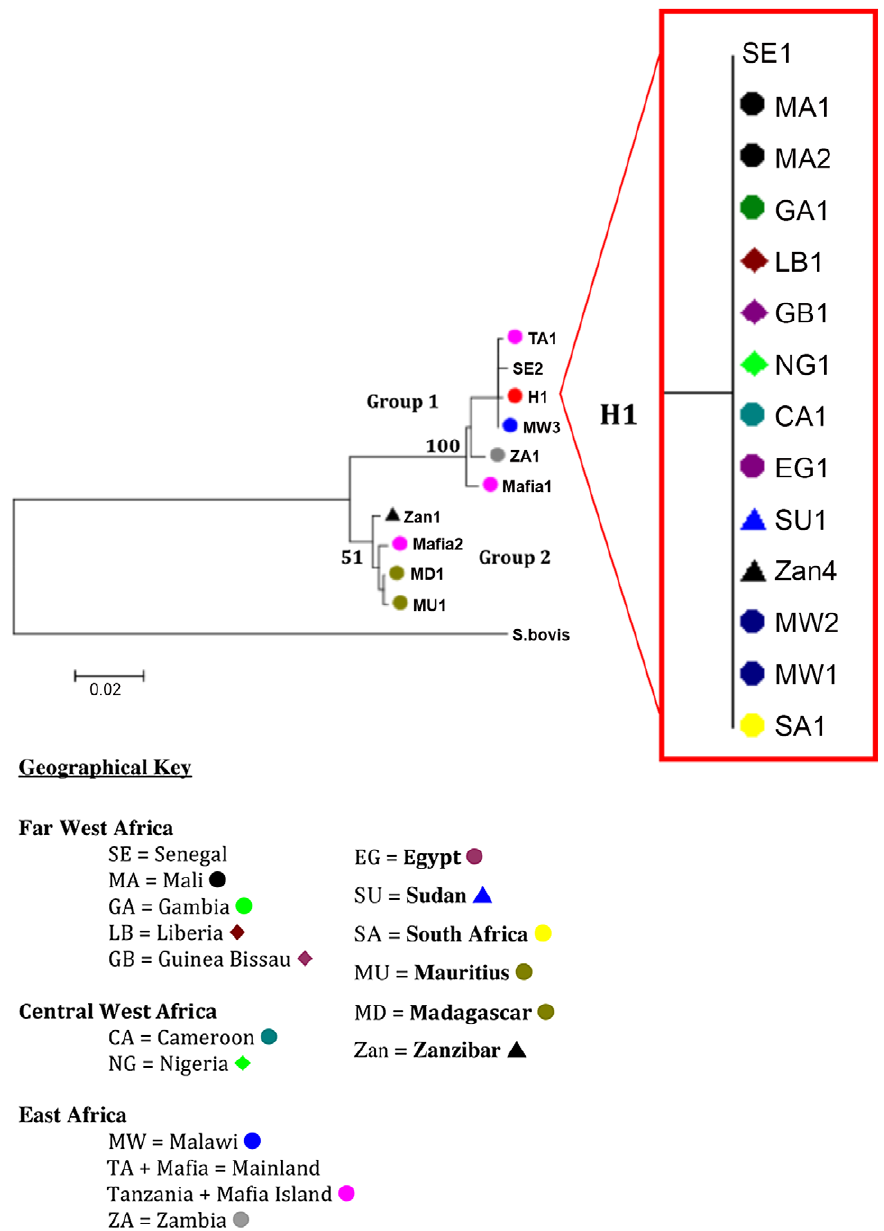
Figure 3. Neighbour-joining nad 1 tree topology supporting the topology of the cox 1 tree. Nodal supports for the 2 groups are marked and details of the samples representing H1, ‘‘red dot’’, are shown in the sub tree. Each terminal branch is labelled with the individual haplotype codes as detailed in Table S1.